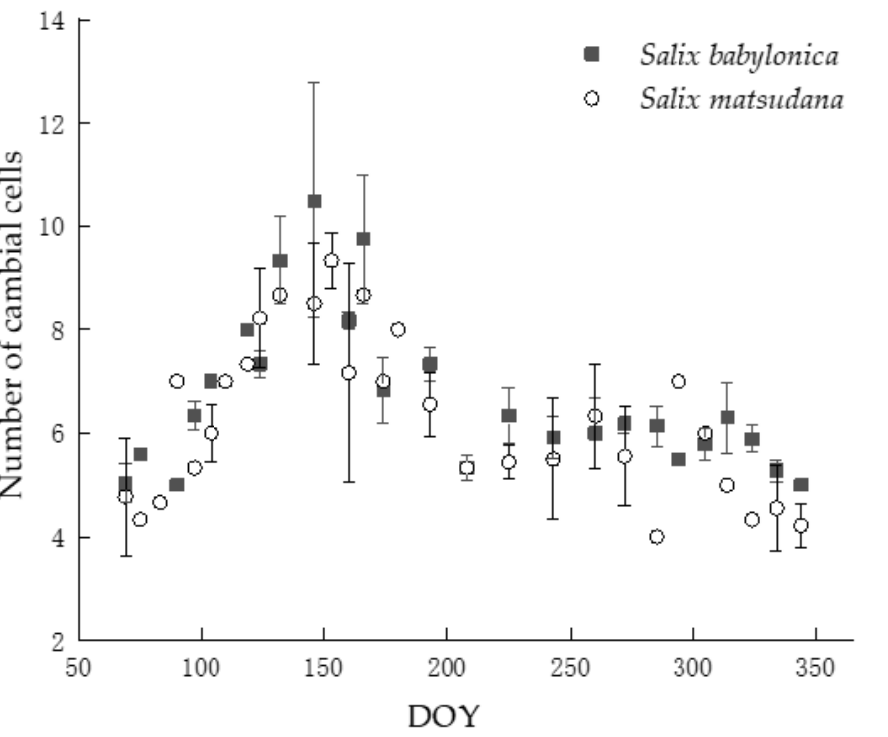
Figure 3. Number of cells observed in the cambial zone of Salix babylonica and Salix matsudana during 2018. Dots and bars represent average number of cells and standard deviations among three trees, respectively.